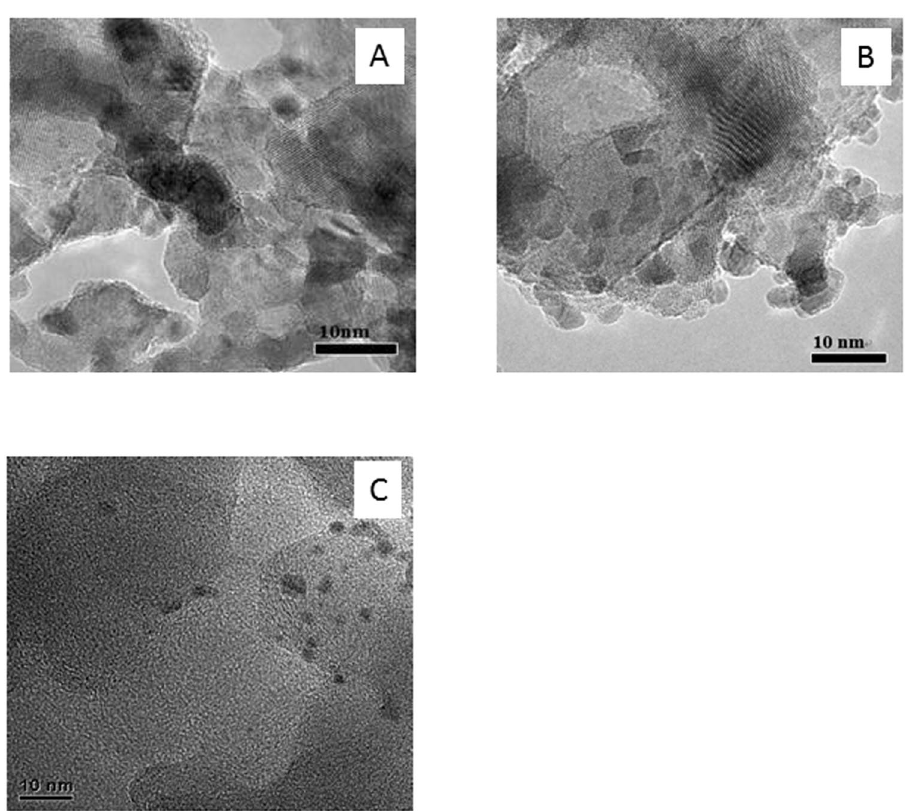
Figure 4. TEM images of Pt/TiO 2 ( A ), Ru/TiO 2 ( B ) and Ru-Cu/C ( C